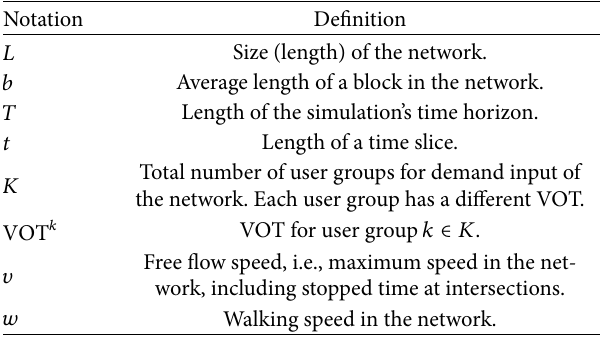
Figure 2: Decision model for on-street and garage parking based on several cost factors. Table 1: Independent variables for parking decision (inputs to the Table 2: Independent variables for parking decision (inputs to the model): traffic network and model parameters. model): on-street and garage parking